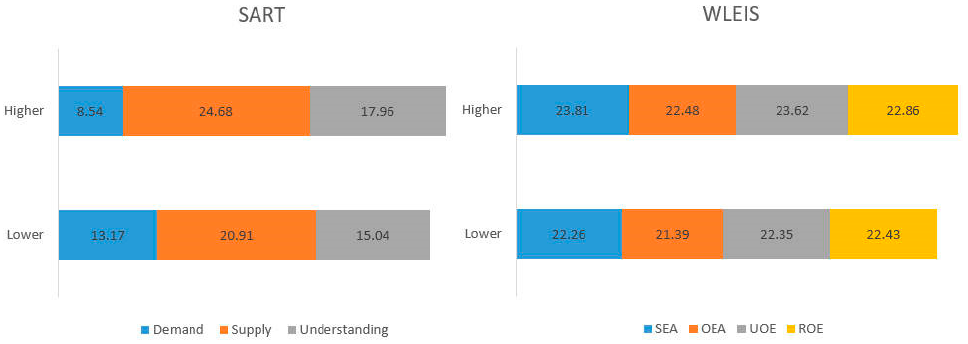
Figure 6. The difference between high and low groups of SART and WLEIS.